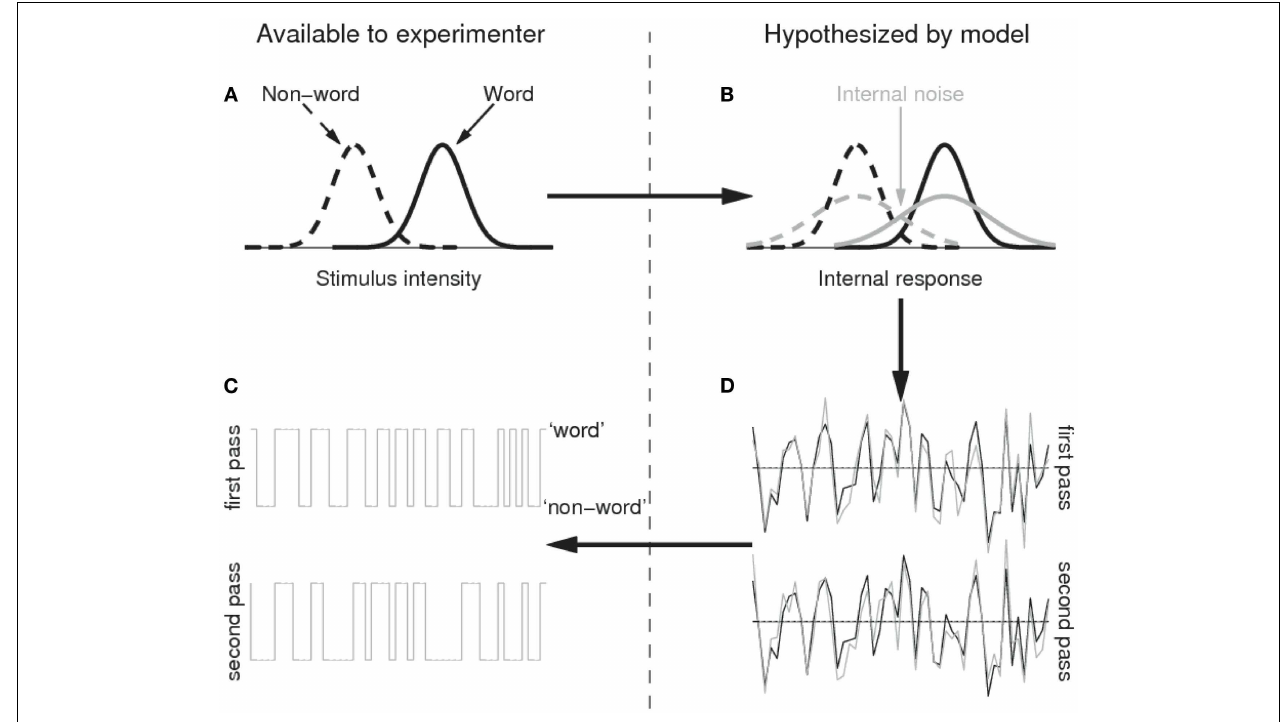
however, the internal responses to the same stimuli differ to some extent between repetitions (D) ; the x axis represents time, the y axis the internal response: e.g., up is evidence toward a word response, down is evidence toward a non-word response) and the word/non-word responses will not be fully consistent (C) . Please refer to Methods for further